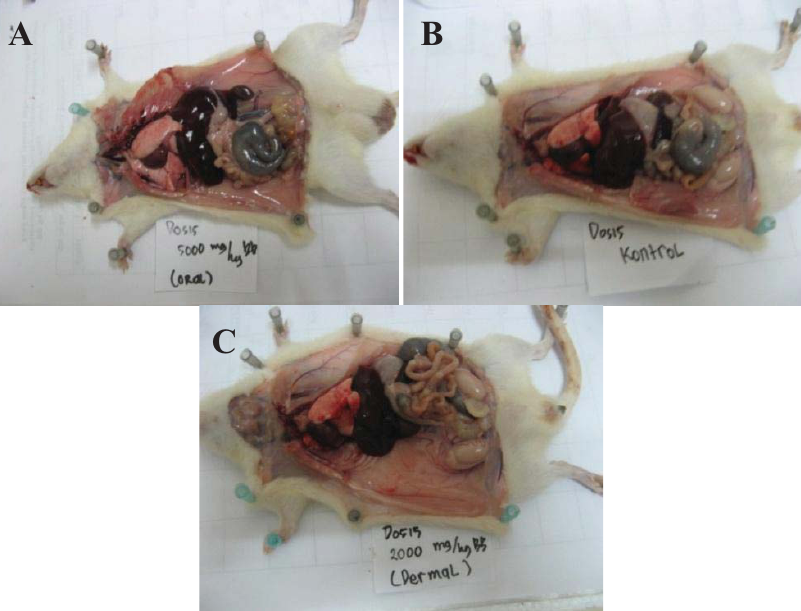
Figure 3. Pictures of the histological evidence of the visceral organ of the mice, control ( A ), oral treatment ( B ) and dermal treatment ( C ).